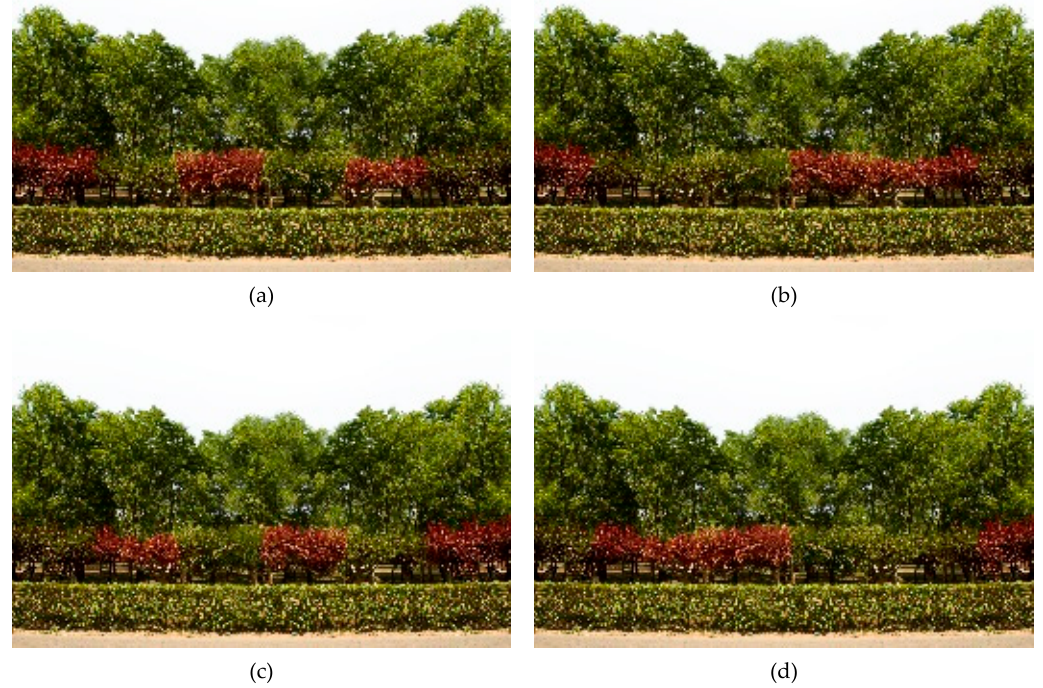
Figure 3 . Examples of different distributions of design color in the midground of Prunus cerasifera in a soft landscape of Sophora japonica in the background and Euonymus japonicus in the foreground. ( a ) L R_U , Red-Single of Location; ( b ) L R_A , Red-Group of Location; ( c ) L G_U , Green-Single of Location; ( d ) L G_A , Green-Group of Location.